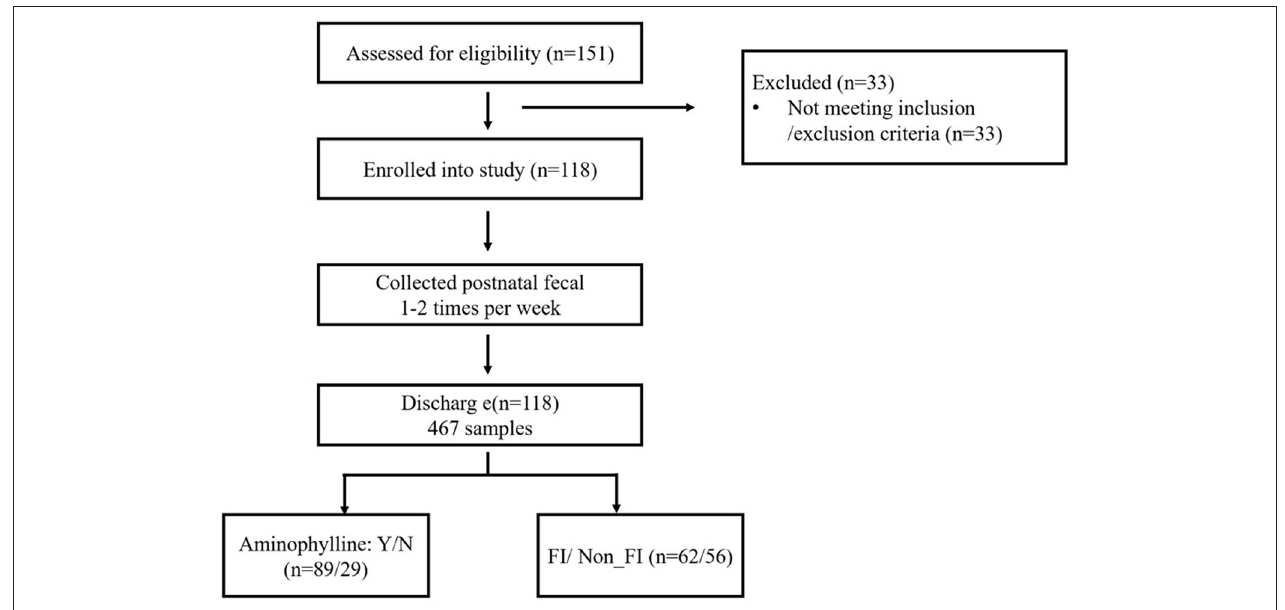
FIGURE 1 | Study flow